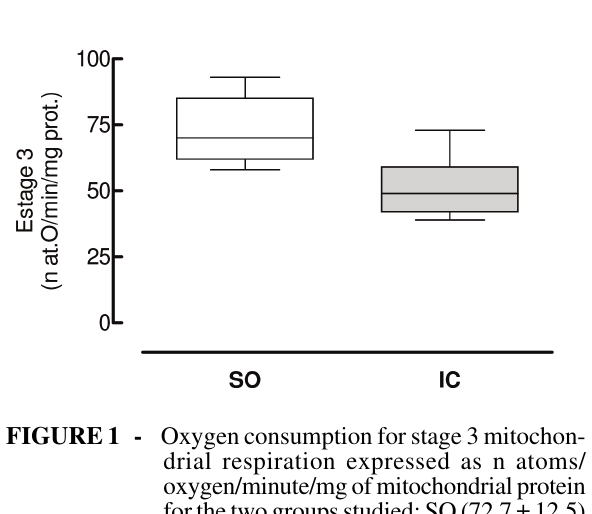
FIGURE 1 - Oxygen consumption for stage 3 mitochon- drial respiration expressed as n atoms/ oxygen/minute/mg of mitochondrial protein for the two groups studied: SO (72.7 ± 12.5)